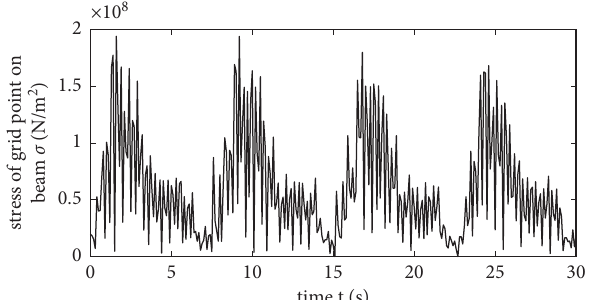
Figure 17: Time history curve of stress of the supporting